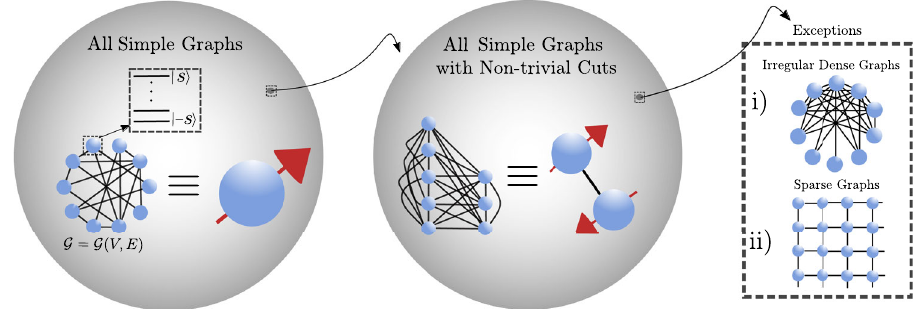
Fig. 1 | In this work we consider a many-body spin s Hamiltonian — see Eq. (1) — de fi nedover a simple graph G ð V , E Þ where the verticesrepresent the spins and